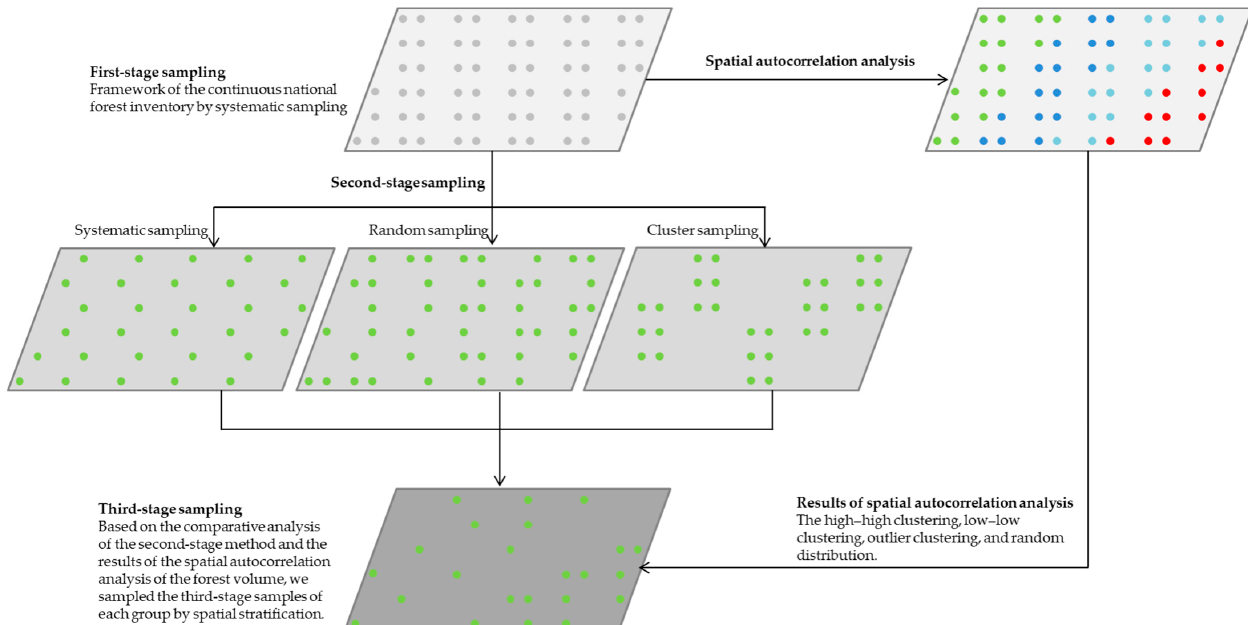
Figure 2. Multistage sampling procedure for estimating the forest volume.